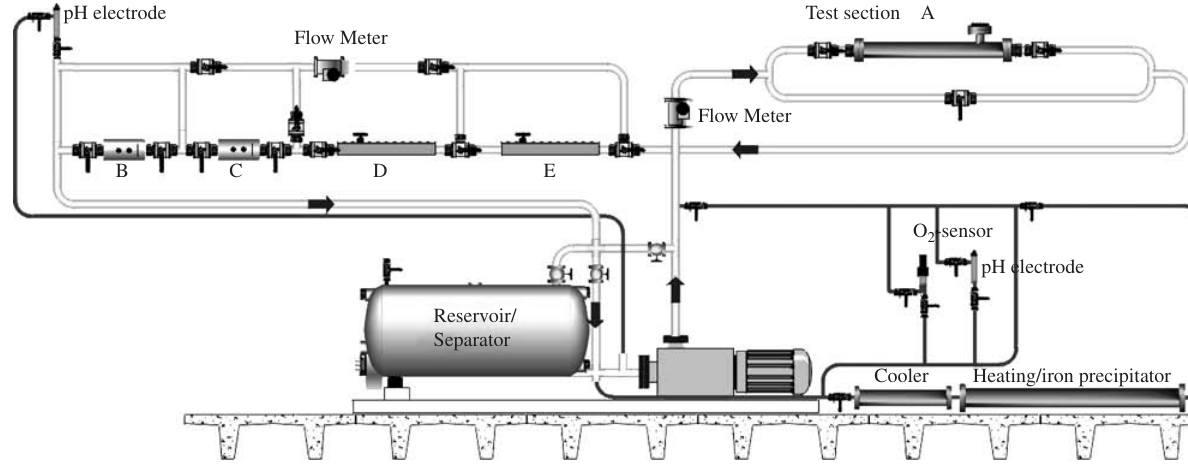
Figure 2. Diagram of flow loop apparatus (Courtesy of IFE, Norway).